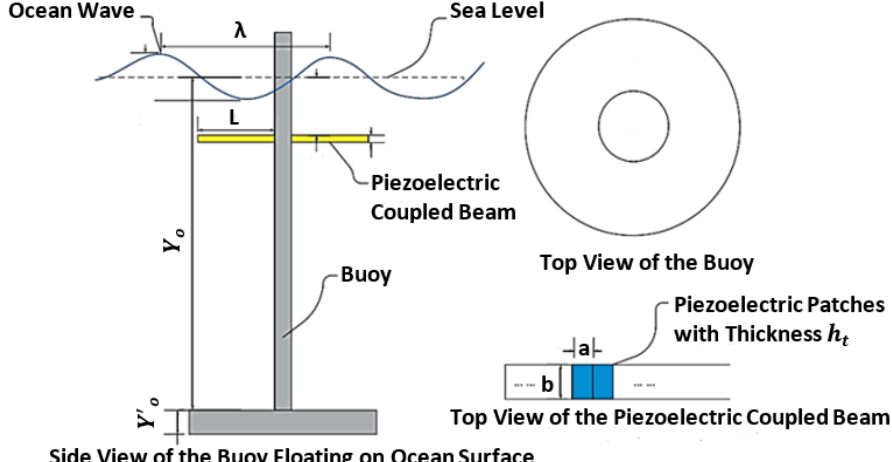
Figure 17. Energy-harvesting buoy schematics [210].